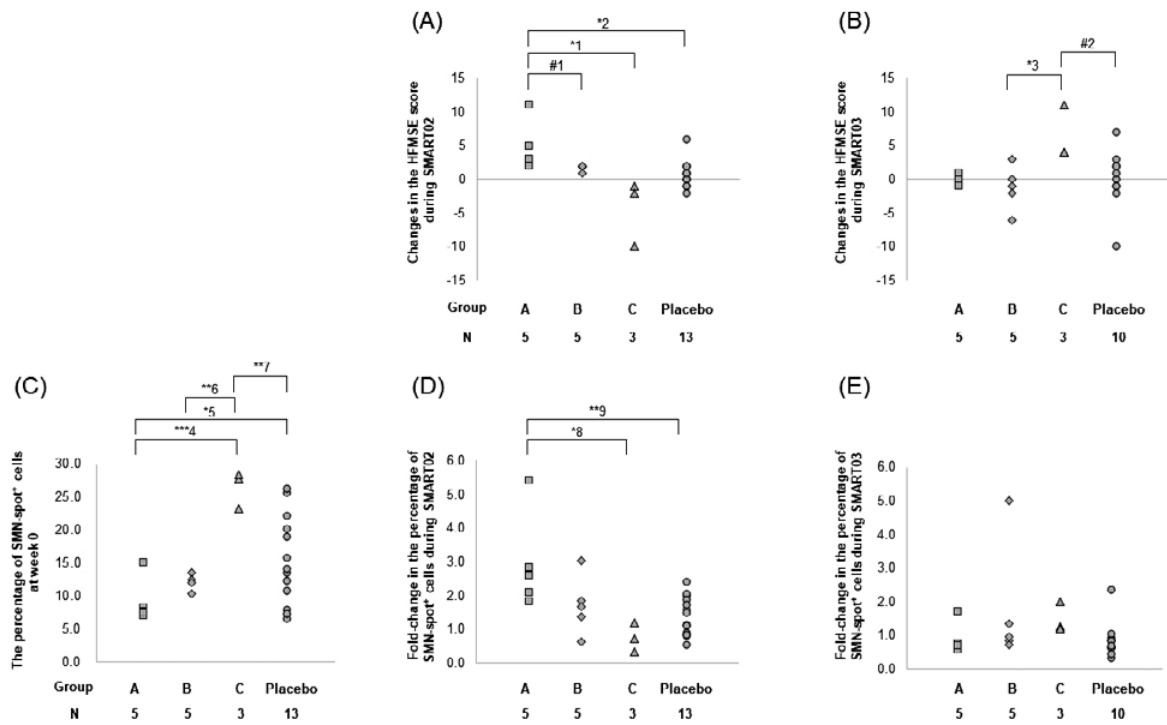
Figure 1. Changes in HFMSE score and SMN protein level in the VPA and placebo groups. (Top) Changes in the HFMSE score during SMART02–SMART03. * p < 0.05; *1: p = 0.0177, *2: p = 0.0463, *3: p = 0.0270, #1 = 0.0629, #2 = 0.0509. (Bottom) Fold-changes in the percent of SMN-spot + cells during SMART02–SMART03. Fold-changes were calculated as the ratio of the final value to the initial value, for each period. * p < 0.05, ** p < 0.01, *** p < 0.001; ***4: p = 0.0005, *5: p = 0.017, **6: p = 0.008, **7: p = 0.002, *8: p = 0.045, **9: p = 0.0046. HFMSE, Hammersmith Functional Motor Scale-Expanded; VPA, valproic acid; SMART, SMA Re- search and